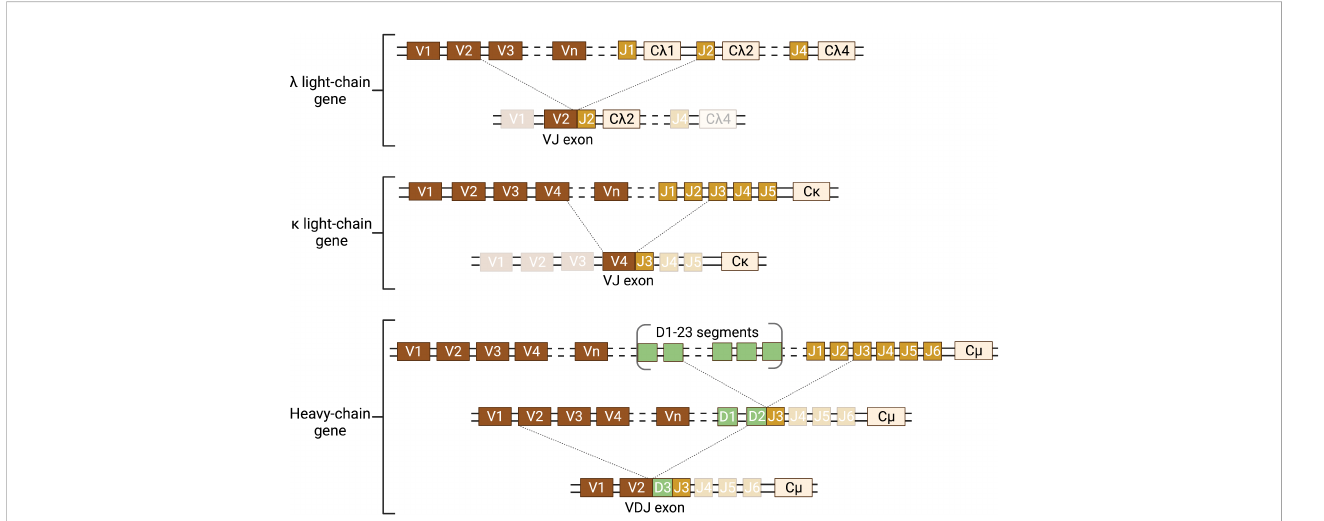
FIGURE 2 Schematic of somatic recombination of the Ig heavy and light chain genes. The Ig genes are inherited in a fragmented, non-functional state and require somatic recombination during B-lymphocyte development to produce Ig protein. There are two light chain genes ( l and k ) and one heavy chain gene and two alleles of each gene. Only one allele of the light chain and heavy chain gene can be functionally expressed in each B lymphocyte. Expression requires DNA recombination to select one variable (V) and one joining (J) segment for the light chain gene and one V, one diversity (D), and one J segment for the heavy chain gene. The recombined VJ (light chain) and VDJ (heavy chain) exons form the antigen binding pocket of the Ig. This random recombination of V(D)J segments allows for the incredible diversity in the antigen binding pocket of Igs. In humans, there are 34-38 V segments, fi ve J segments and one constant (C) segment for the k light chain; 29-33 V, 4-5 J, and 4-5 C segments for the l light chain; and 38-46 V, 23 D, 6 J, and 9 C segments for the heavy chain. The schematic illustrates a hypothetical somatic recombination of one allele for each of the l and k light chains and the heavy chain. However, each B lymphocyte will only successfully recombine one light chain and one heavy chain allele. Recombination of the light chain genes requires one recombination of V to J; whereas the heavy chain requires two recombination events, fi rst D to J and then V to DJ. Dotted lines represent the location of the double strand cut (top) and the recombined segments forming the coding exon (bottom joining of lines). Transcription is initiated at the 5 ′ end of the recombined exon and terminated at the 3 ′ end of the C exon. Figure was created with BioRender.com.